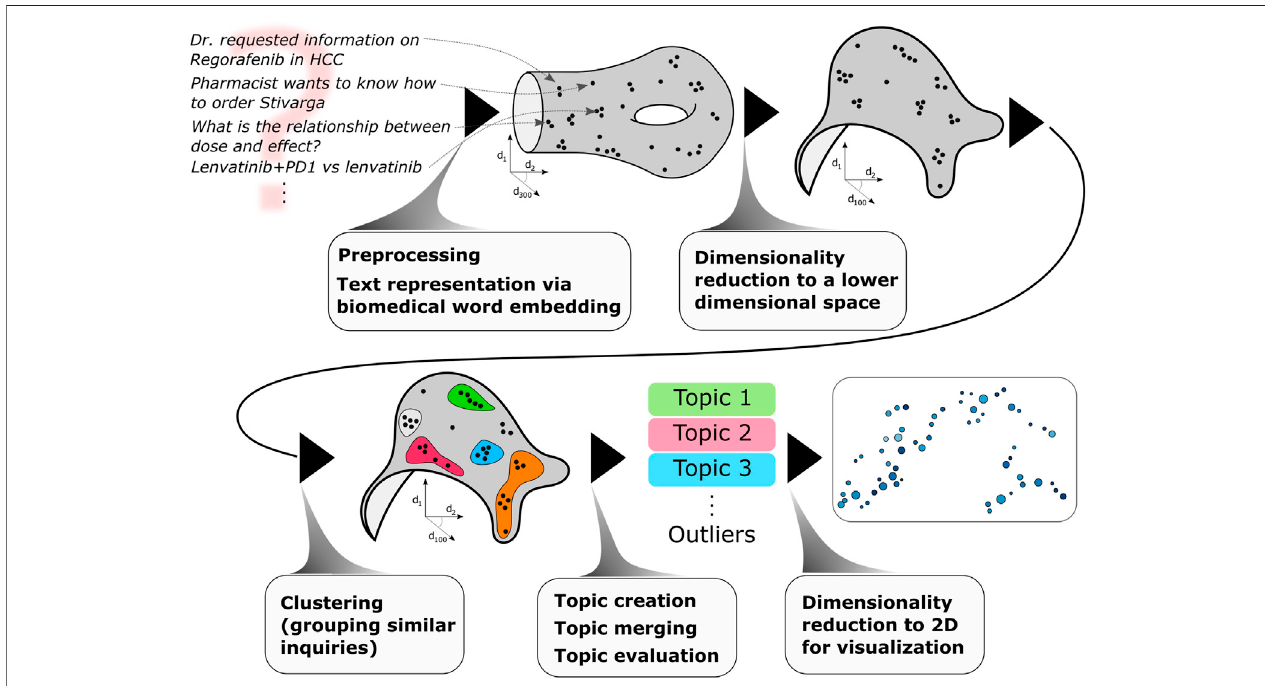
FIGURE 1 | From medical inquiries to medical topics via natural language processing and machine